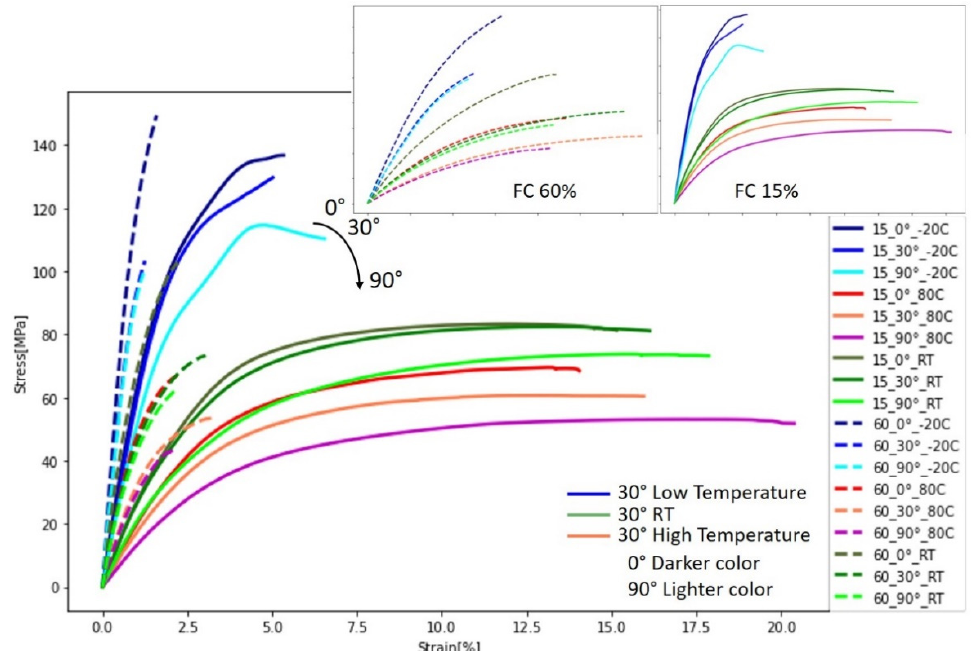
Figure 3. Experimental tensile test curves for PA46 GF60 and PA46 GF15 with all three fiber orientations (0°, 30°, and 90°) for 3 mm (in small boxes; curves are shown separately according to the fiber contents GF15 and GF60).